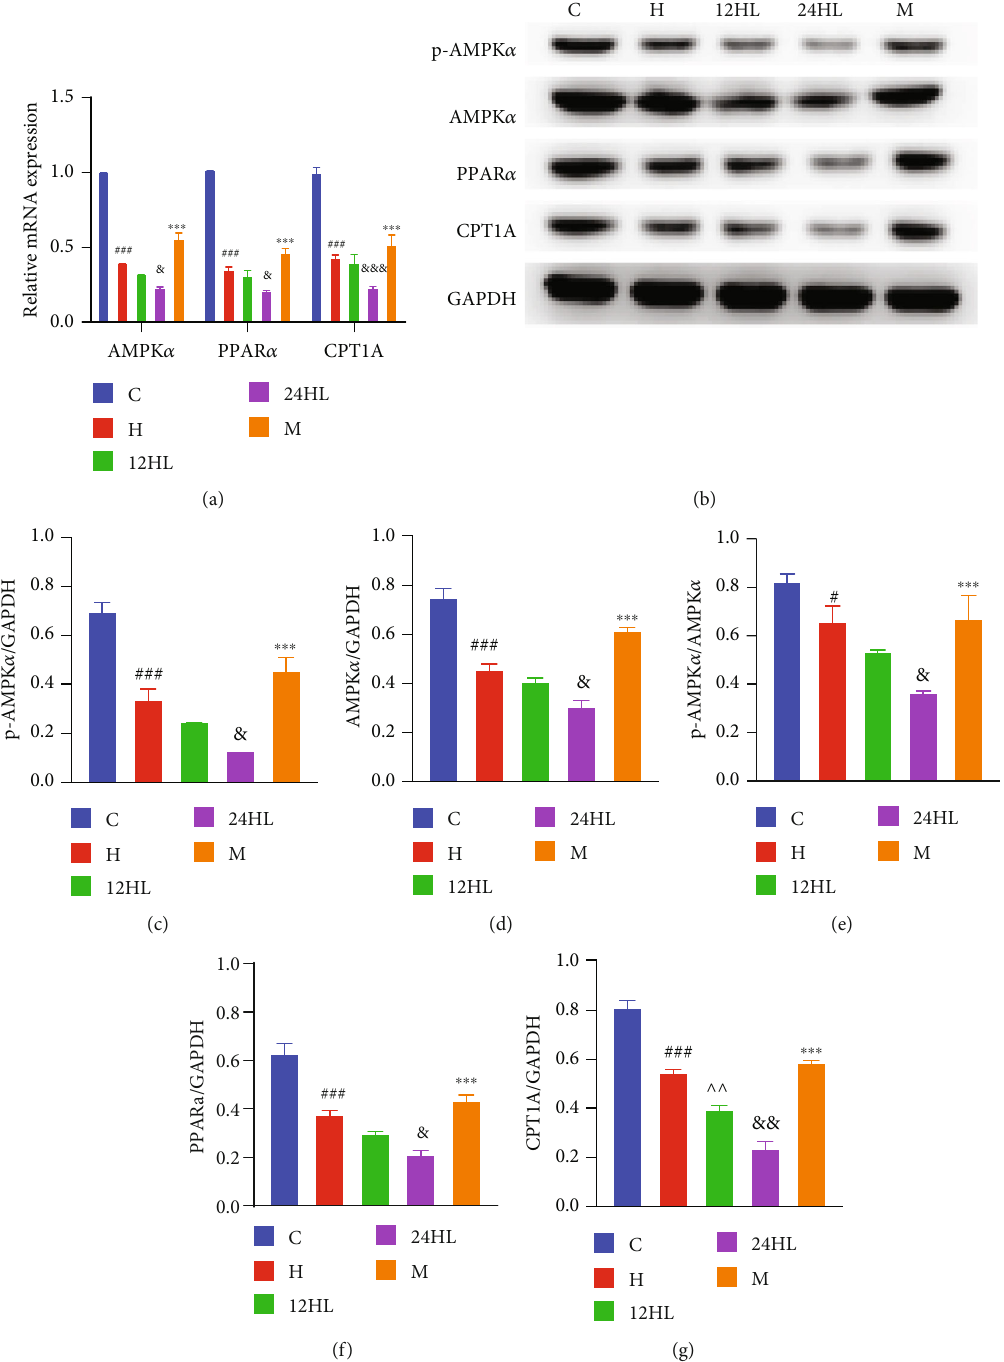
Figure 7: E ff ects of melatonin on AMPK signaling pathway-related mRNA and protein expression levels in guinea pig hepatic tissue after treatment, at week 10. (a) AMPK α , PPAR α , and CPT1A mRNA expression as revealed by quantitative reverse-transcription PCR. (b) Western blotting of p-AMPK α , AMPK α , PPAR α , and CPT1A. p-AMPK α (c), AMPK α (d), p-AMPK α /AMPK α (e), PPAR α (f), and CPT1A (g) protein expression was quantitated by densitometry analysis of the bands. Values were normalized against that for GAPDH and analyzed with ImageJ software. C: control group; H: HFD group; 12HL: 12h light group; 24HL: 24 h light group; M: melatonin group; AMPK α : AMP-activated protein kinase α ; p-AMPK α : phosphorylated AMPK α ; p-AMPK/AMPK: protein ratio between p-AMPK and total-AMPK; PPAR α : peroxisome proliferator-activated receptor- α ; CPT1A: carnitine palmitoyl-CoA transferase 1 A; GAPDH: glyceraldehyde-3-phosphate dehydrogenase. The values are expressed as the means ± S : D : ( n = 3 per group). # P < 0 : 05 and ### P < 0 : 001 , HFD vs. control; ^^ P < 0 : 01 , 12HL vs. HFD group; & P < 0 : 05 , && P < 0 : 01 , and &&& P < 0 : 001 , 24HL vs. 12HL group; ∗∗∗ P < 0 : 001 , M vs. 24HL